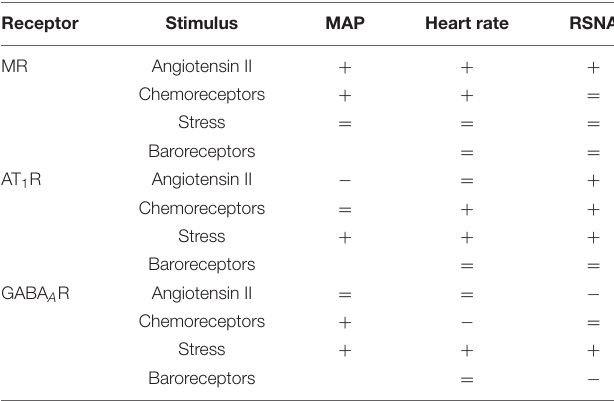
TABLE 4 | Summary of effects of stimuli on receptor signaling in the